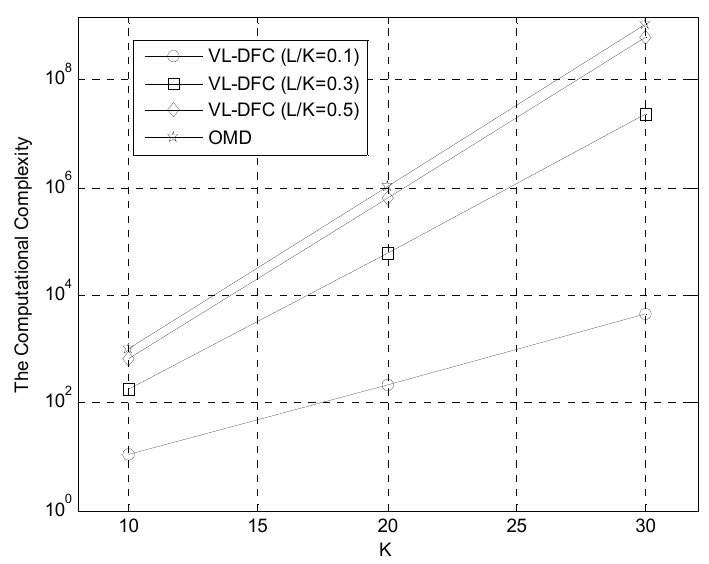
Figure 4. The computational complexity of VL-DFC and OMD.